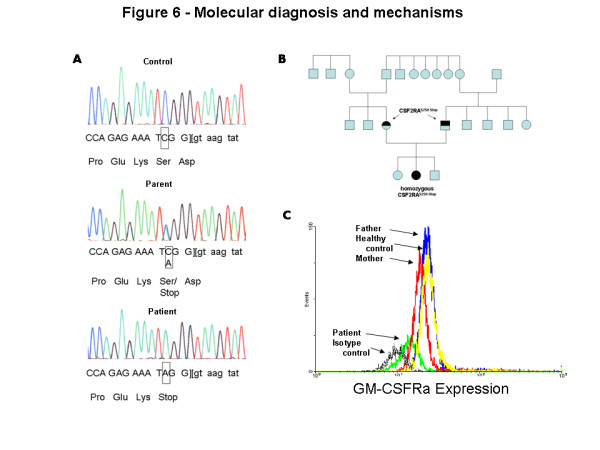
Molecular diagnosis and mechanism. Sequence analysis of CSF2RA exon 3 in a control subject (Figure. 6 A, upper panel), in one of the parents (Figure. 6 A, middle panel), and in the proband (Figure. 6 A, lower panel). In peripheral blood leukocytes genomic DNA, exons 3-13 of the CSF2RA gene were amplified and the PCR products were sequenced. The electropherograms illustrate the c.74 C > A substitution (boxed) in heterozygous (middle panel) and in homozygous form (lower panel), which leads to the replacement of a serine (TCG) by a premature stop codon (TAG) at amino acid position 25. Family tree shows consanguinity (Figure. 6 B). Flow cytometric analysis of peripheral blood cells demonstrates the absence of the alpha-chain (Figure. 6 C). Isolated neutrophils were incubated with antibodies, washed with Dulbecco's PBS twice and measured by means of flow cytometry. Ten thousand cells were counted and analyzed by the FACSDiva software. Fc blocking and isotype controls were applied to exclude unspecific bindings. CD11b (mouse monoclonal IgG1, PE conjugated), CD116/GM-CSF-R alpha (mouse monoclonal IgG1, PE conjugated), CD131w/GM-CSF-R beta (mouse monoclonal IgG1, purified) and secondary antibody for CD131w (rat anti-mouse IgG1, PE-conjugated).